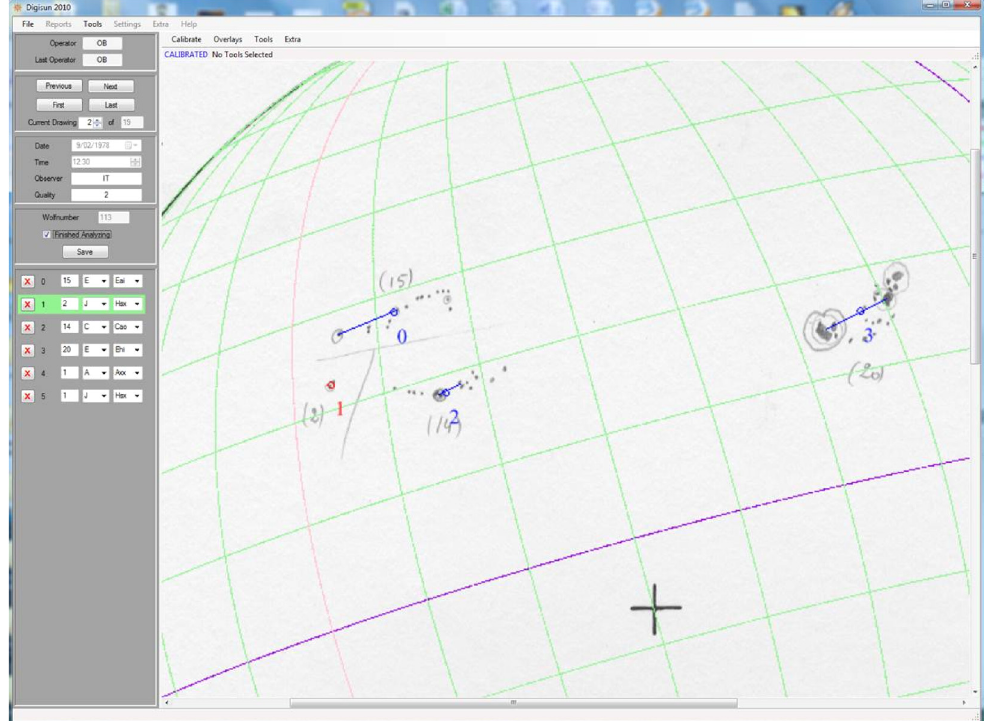
Fig. 8. Graphical User Interface of the DigiSun application developed at the Royal Observatory of Belgium for measuring digitized drawings from the 70-year collection of the Uccle station. This is an example of modern tools than can help recovering detailed though so far unexploited information in historical series of sunspot observations, either visual or photographic.